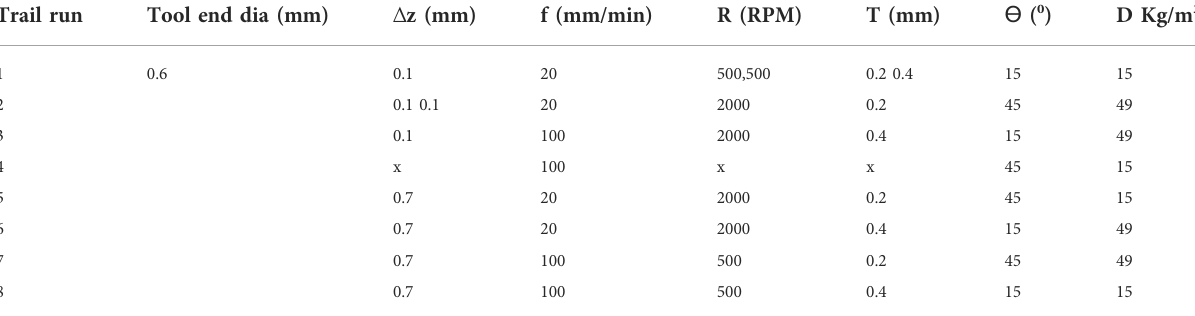
TABLE 1 Taguchi L8 experiment set for SPIF with two-level numeric values of input parameters. Trail